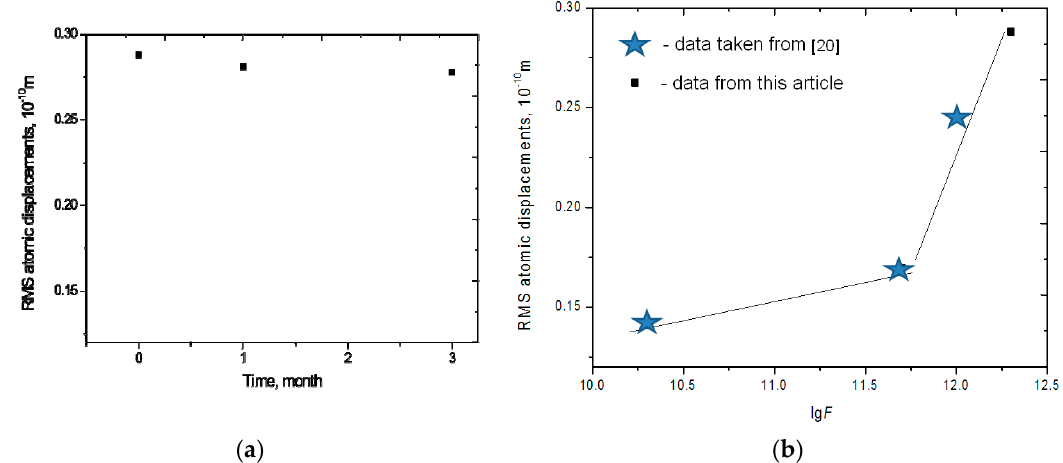
Figure 4. (a ) Temporal dynamics in RMS displacement of the sample irradiated with a dose of 2 × 10 12 ions/cm 2 and ( b ) RMS displacement immediately after irradiation for four fluences between 5 × 10 10 and 2 × 10 12 ions/cm 2 (data for the first three taken from [20]).